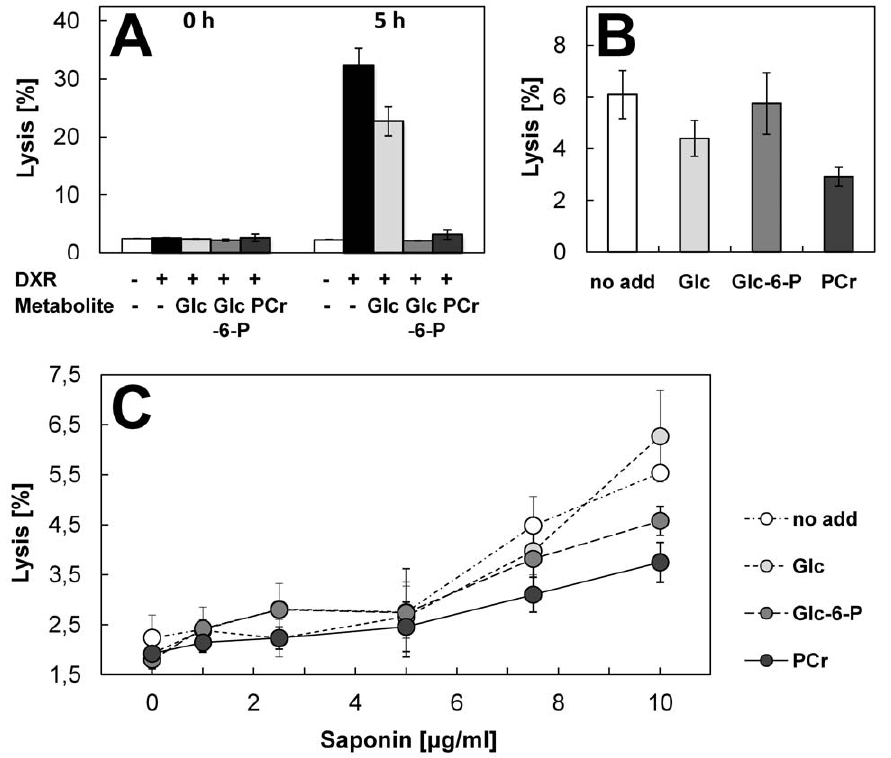
Figure 6. Phosphocreatine protects red blood cells against doxorubicin-, saponin- and hypoosmotic stress- induced lysis. Red blood cells isolated from fresh pig blood were preincubated for 10 min without any additions or in presence of 50 mM PCr, glucose (Glc) or glucose-6- phosphate (Glc-6-P). Hemolysis was induced by (A) 300 m M doxorubicin (DXR) at 37 u C, (B) incubation for 10 min at 200 mOsm at room temperature, or (C) incubation with 1–10 m g/ml saponin for 10 min at room temperature. Data in (A) were corrected for absorbance of doxorubicin; hemolysis was evaluated directly (0 h) and 5 h after addition of doxorubicin. Stability of PCr under the given experimental condition was verified by HPLC. Data are given as mean 6 SD (n=3). Note: Glc-6-P also exerts a protective